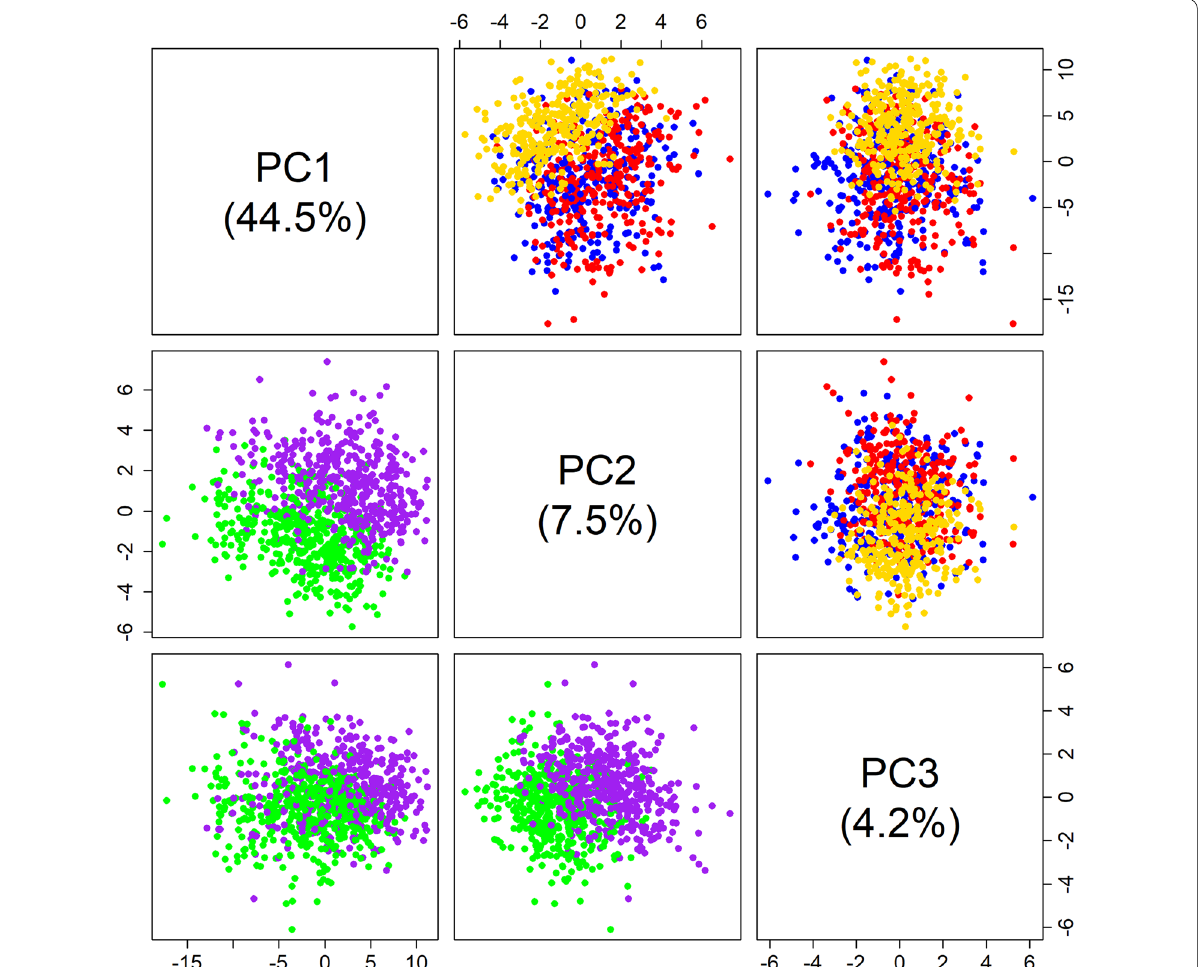
Fig. 5 Matrix plot of first three PCs of log 10 relative abundances. Points are colored by preservative method in the upper panel (gold is GRC, blue is TNx2 and red is GHx2) and sampling round in the lower panel (round 1 is green and round 2 is